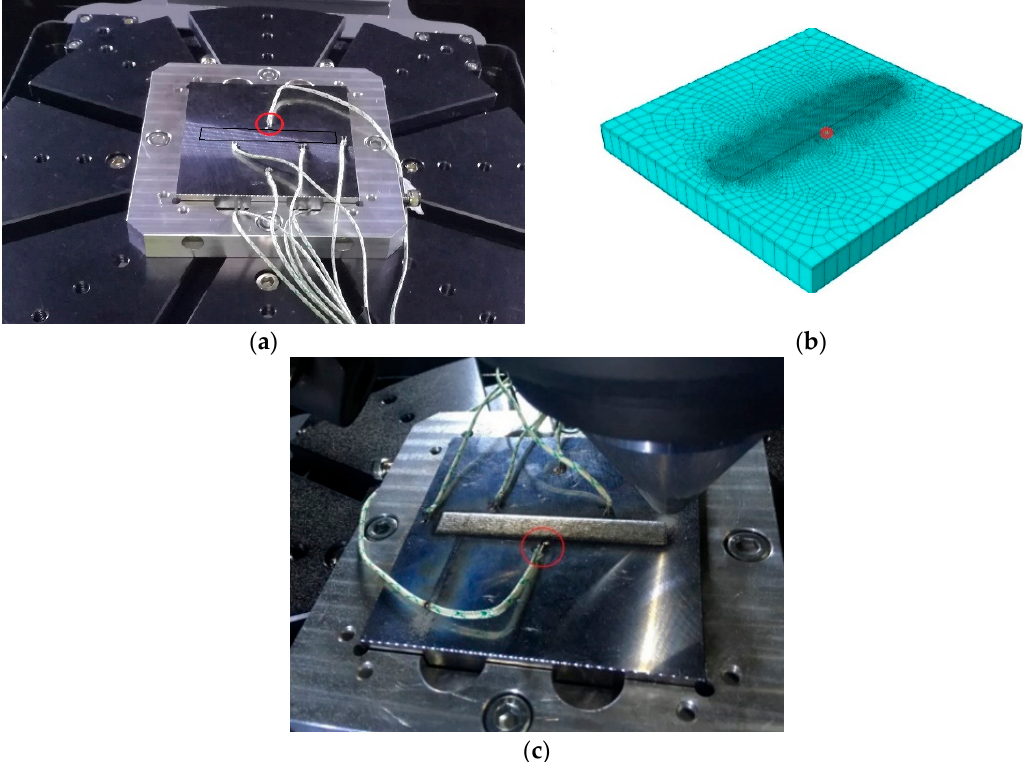
Figure 9. ( a ) Picture of 19 tracks deposition base plate mounted on 3D printing holder and thermocouple position marked with red circle selected to compare temperature evolution with numerical results; ( b ) Meshed model and the nodal position selected for comparison with the experimental results; ( c ) Deposited sample captured after the experiment.